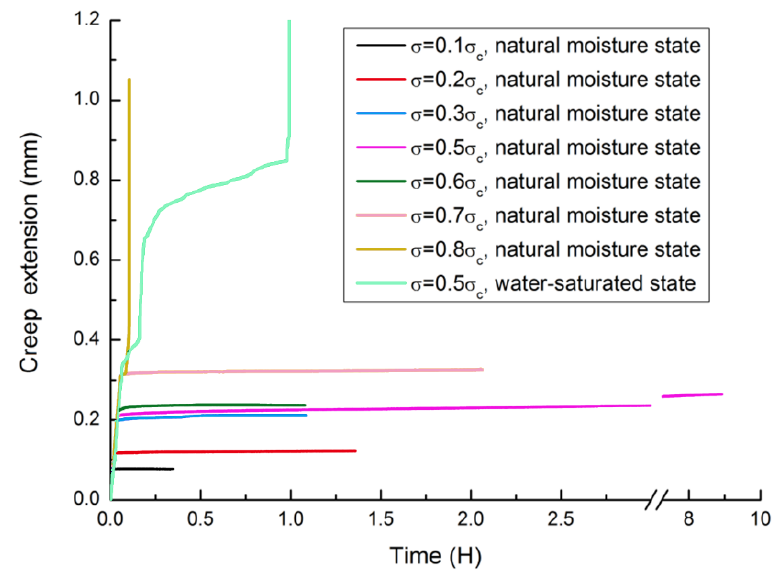
Figure 7. Red shale’s creep experiments result in different constant loading and water effect.